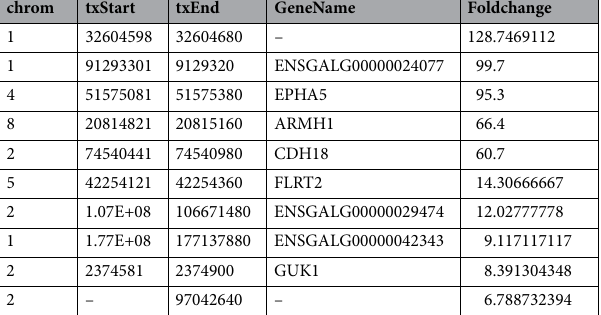
chrom txStart txEnd GeneName